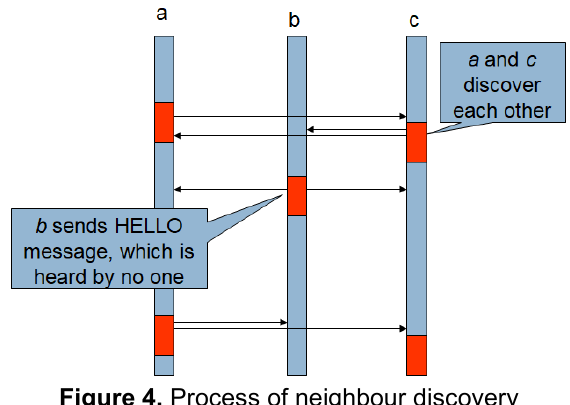
Figure 4. Process of neighbour